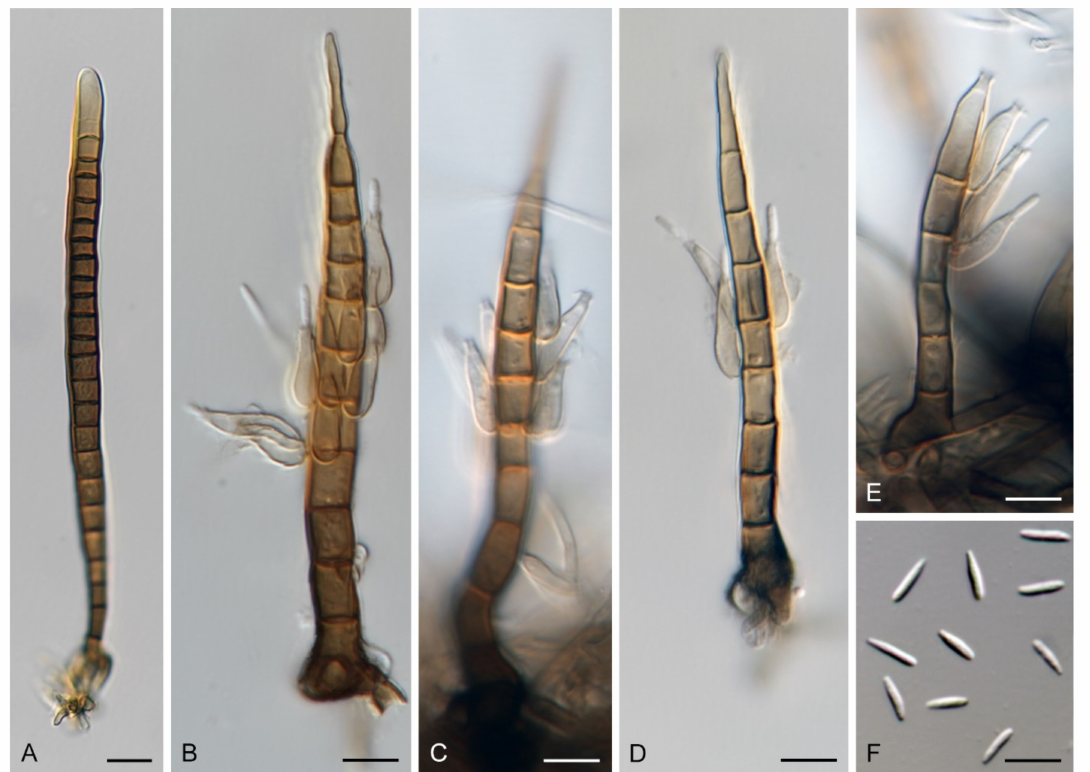
Figure 11. Zanclospora clavulata (CBS 146967 ex-type). ( A ) stanjehughesia-like conidiophores. ( B – E ) Zanclospora conidio- phores. ( F ) Microconidia. Images: ( A – F ) on CMA with U. dioica stems after 4 weeks. Bars: ( A ) = 10 µ m; ( B – F ) = 5 µ